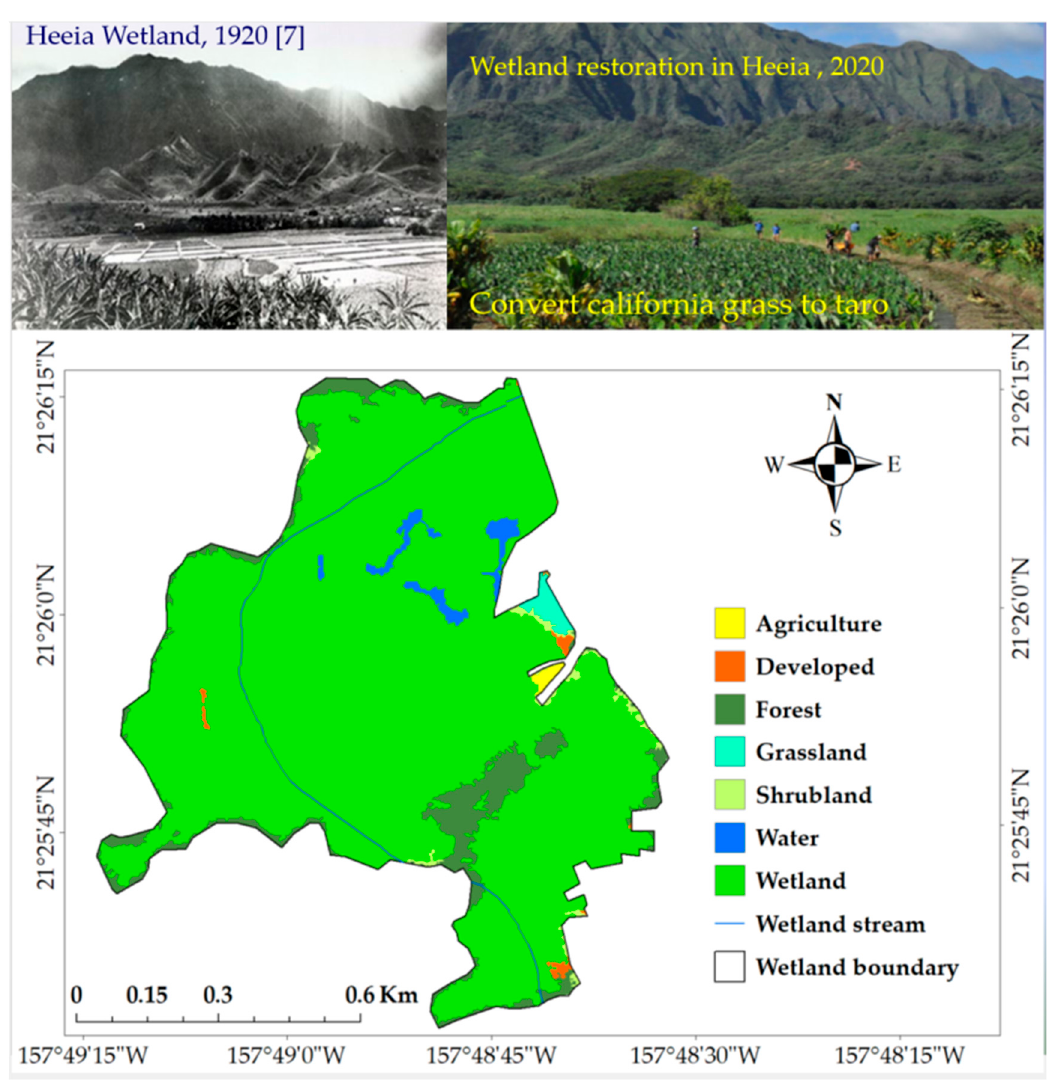
Figure 2. The pre-development ( top, left ) and current land use ( top, right and bottom ) maps of the Heeia wetland. Please note that palustrine scrub shrub, emergent, forested, and estuarine wetlands were reclassified as “wetland” on the wetland area map for clarity.